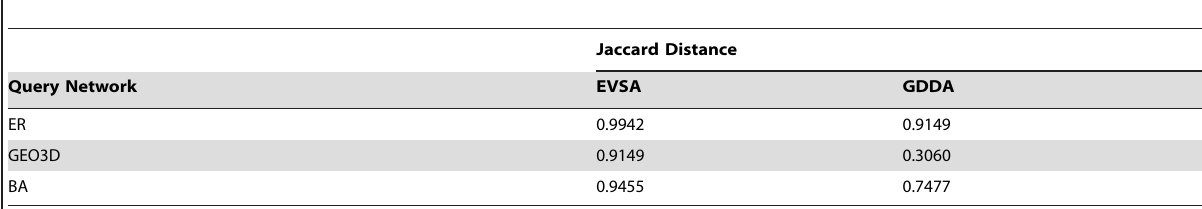
Table 5. The Jaccard Distance of GDDA and EVSA between matching and mismatching network